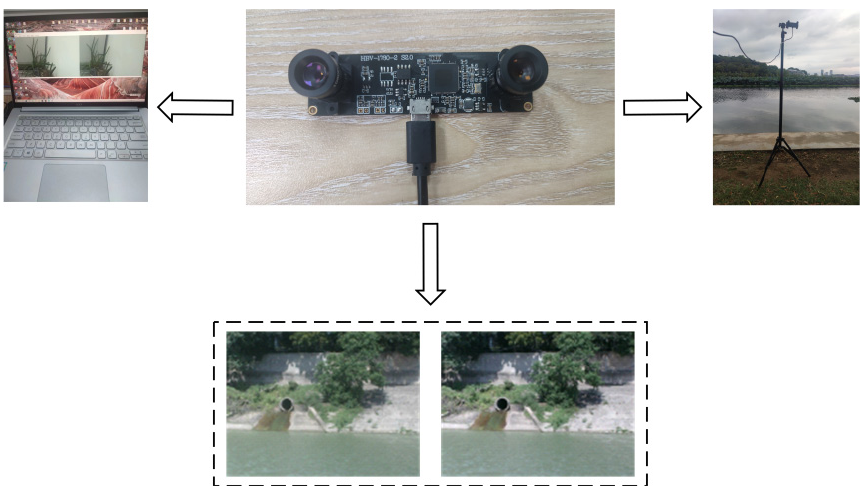
Figure 3. Working principle of the binocular image acquisition system.